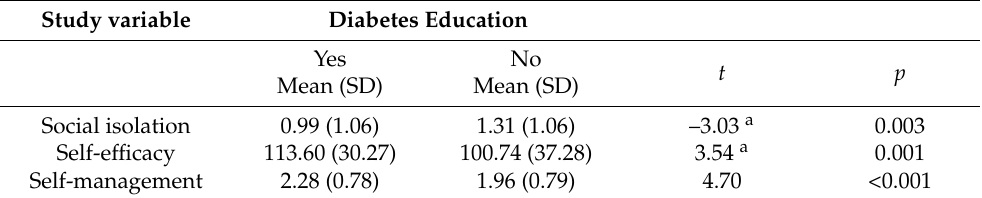
Table 3. Mean differences in social isolation, self-efficacy, and self-management according to dia- betes